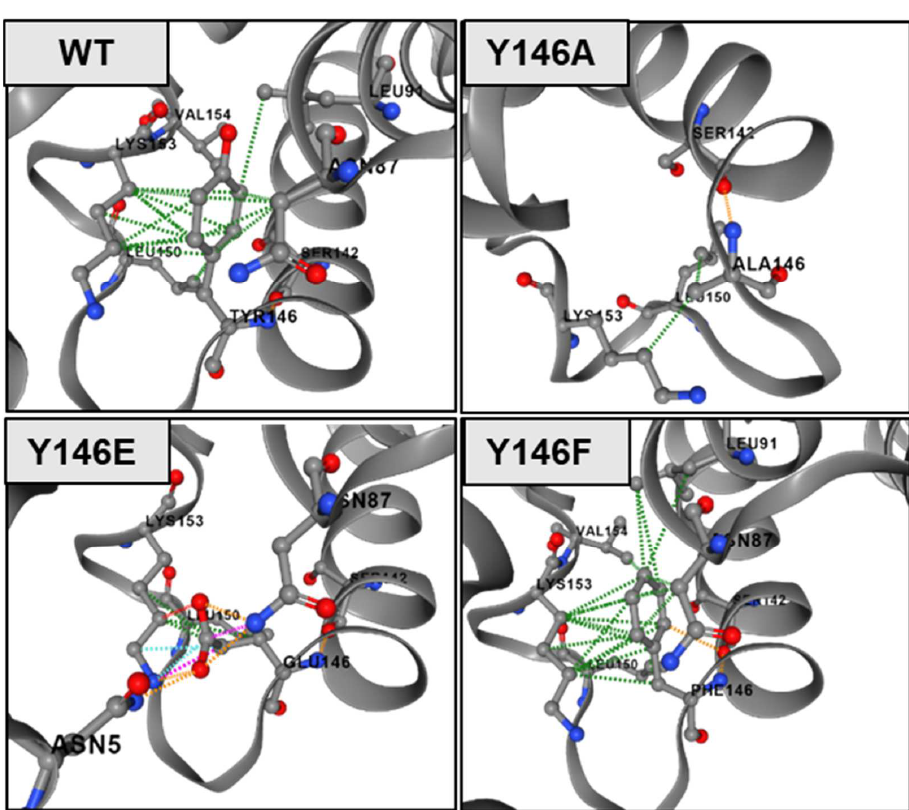
Figure 8. Visual representation of interatomic interactions at amino acid position 146 of wt and mutant NTCP proteins. Hydrophobic interactions are depicted as dotted green lines, ionic interaction in orange and steric clashes (unnatural overlap of two non-bonding atoms) in pink based on the AlphaFold structure of human NTCP (AF-Q14973-F1).